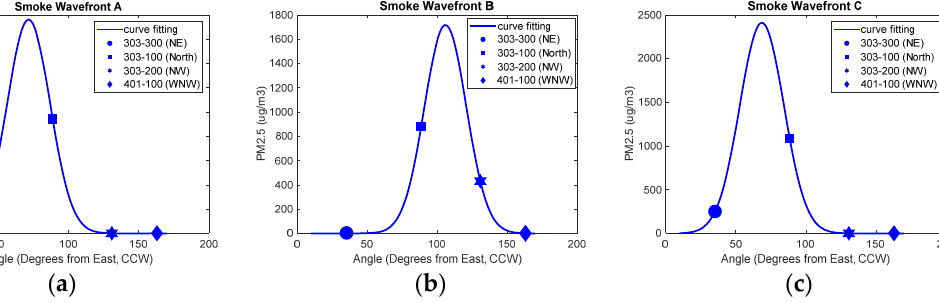
Table A2. PM 2.5 Emission calculation from ground level smoke ‐ wave A.